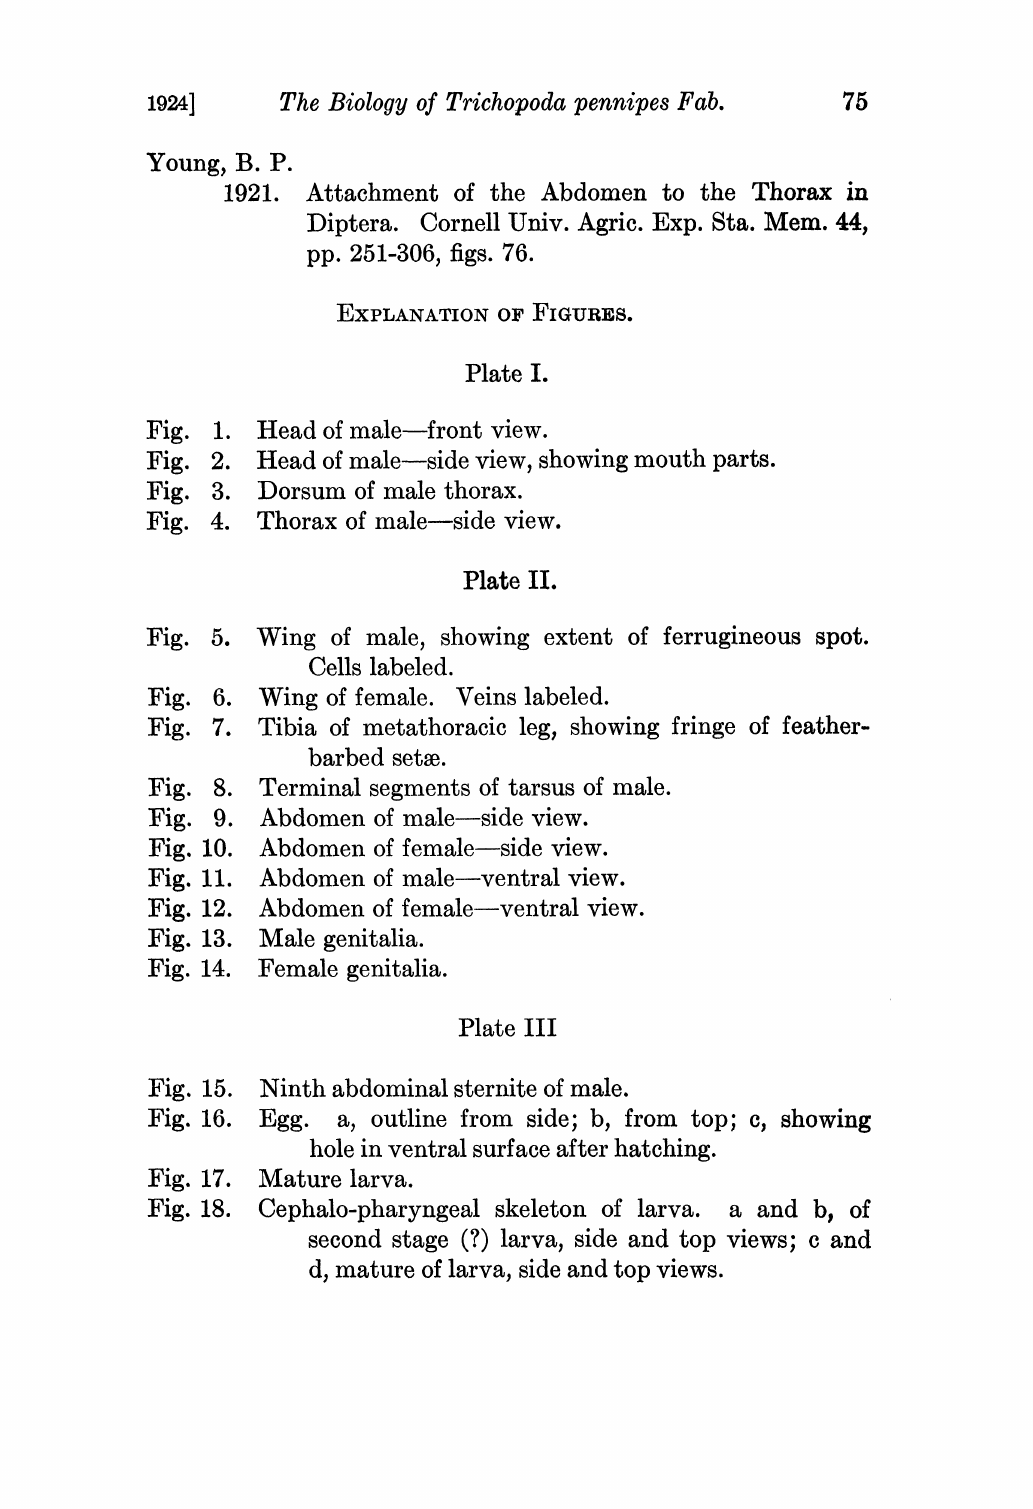
Head of male--front view. Head of malewside view, showing mouth parts. Dorsum of male thorax. Fig. 3. Thorax of male--side view. Fig. 4. Plate II. Wing of male, showing extent of ferrugineous spot. Cells labeled. Wing of female. Veins labeled. Tibia of metathoracic leg, showing fringe of feather- barbed setm. Terminal segments of tarsus of male. Abdomen of male--side view. Abdomen of female--side view. Abdomen of male--ventral view. Abdomen of female--ventral view. Male genitalia. Fig. 13. Female genitalia. Fig. 14. Plate III Ninth abdominal sternite of male. Egg. a, outline from side; b, from top; c, showing hole in ventral surface after hatching. Mature larva. Cephalo-pharyngeal skeleton of larva, a and b, of Fig. 18. second stage (?) larva, side and top views; c and d, mature of larva, side and top